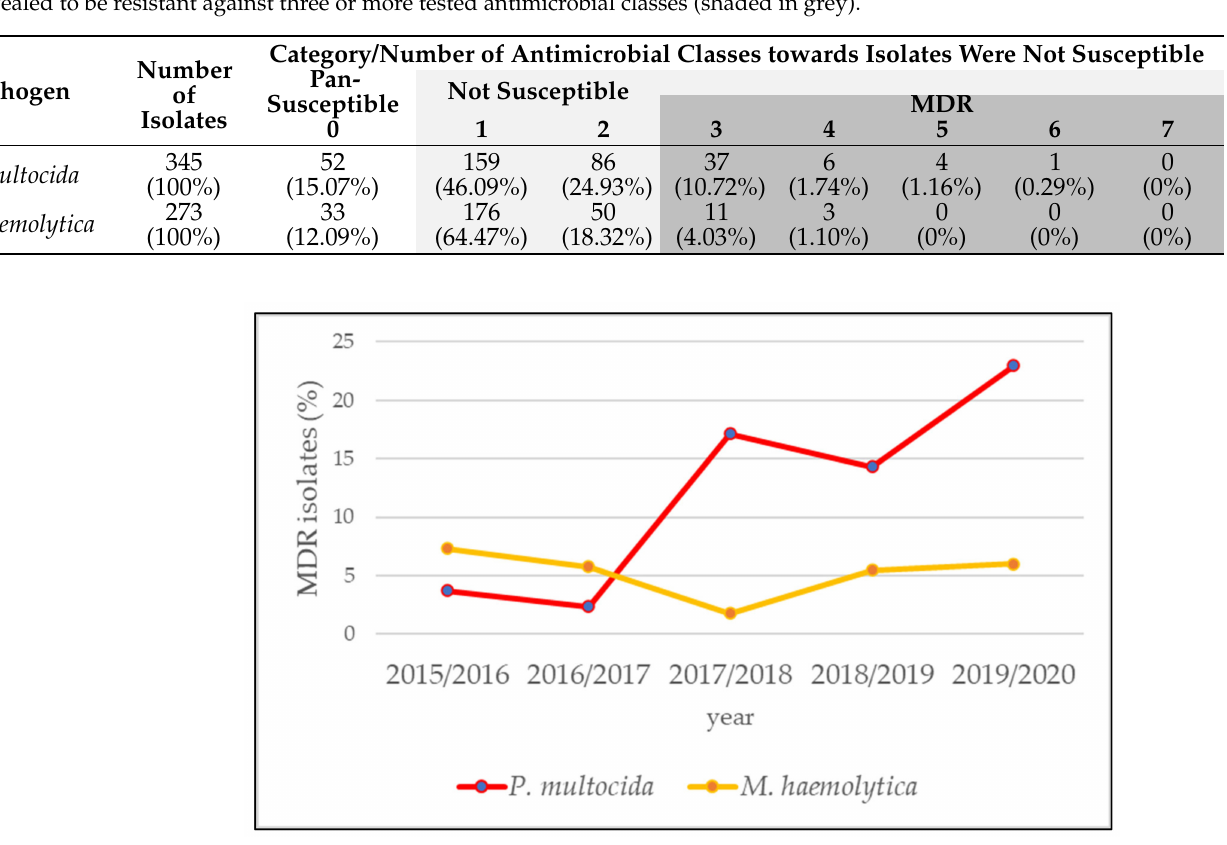
Figure 3. Annual multidrug-resistance (MDR) rates of the bacterial pathogens P. multocida and M. haemolytica from cattle with bovine respiratory disease (BRD) in Bavaria, Germany. A significant in- crease of MDR P. multocida isolates could be observed over the five-year period 2015–2020 (OR = 1.61; 95% CI: 1.25–2.14; p <